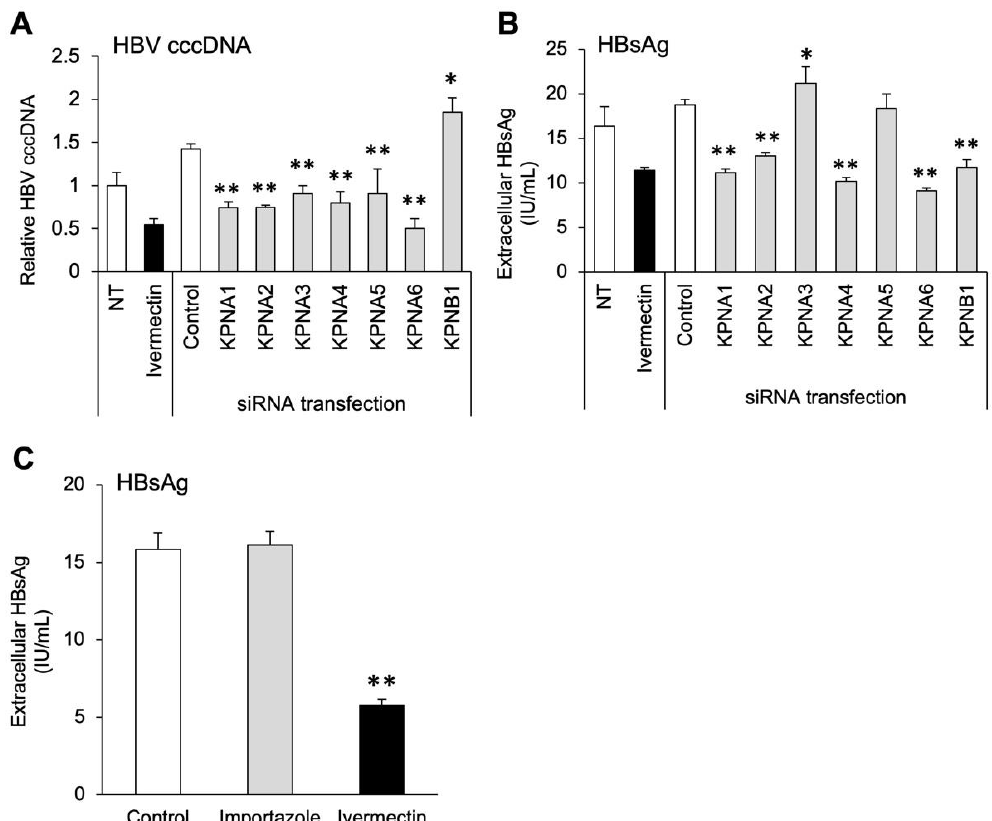
Figure 6. Multiple subtypes of importin α were involved in HBV infection. ( A,B ) Levels of intracellular cccDNA and extracellular HBsAg at day 9 after HBV infection. HepG2-hNTCP-C4 cells were treated with 10 μM ivermectin for 48 h. siRNAs targeting KPNA1– 6 and KPNB1 (20 nM) were transfected at cell seeding. NT, non-transfection. The cccDNA level of the NT group was defined as 1. ( C ) Extracellular HBsAg levels at day 9 after HBV infection. HepG2-hNTCP-C4 cells were treated with 10 μM ivermectin or 10 μM importazole for 48 h. Data are presented as the mean ± SD [ (A), n = 3; (B), n = 4]. * p < 0.05, ** p < 0.01 (A, B: vs. siRNA control).